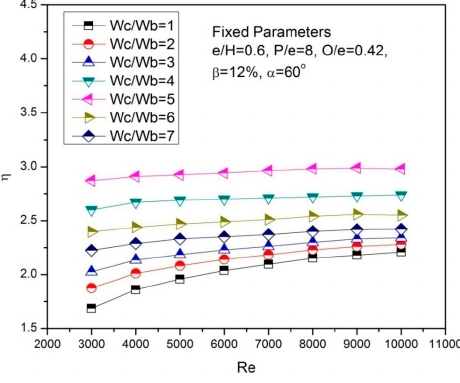
Figure 10. Variation of the thermo-hydraulic performance parameters ( η ) with Wc/Wb .